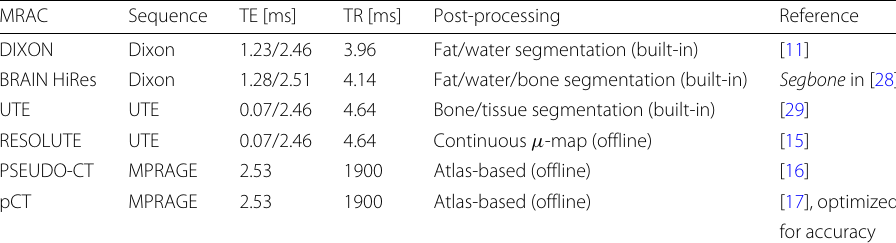
Table 1 MR-based attenuation correction methods with their sequence parameters and post-processing